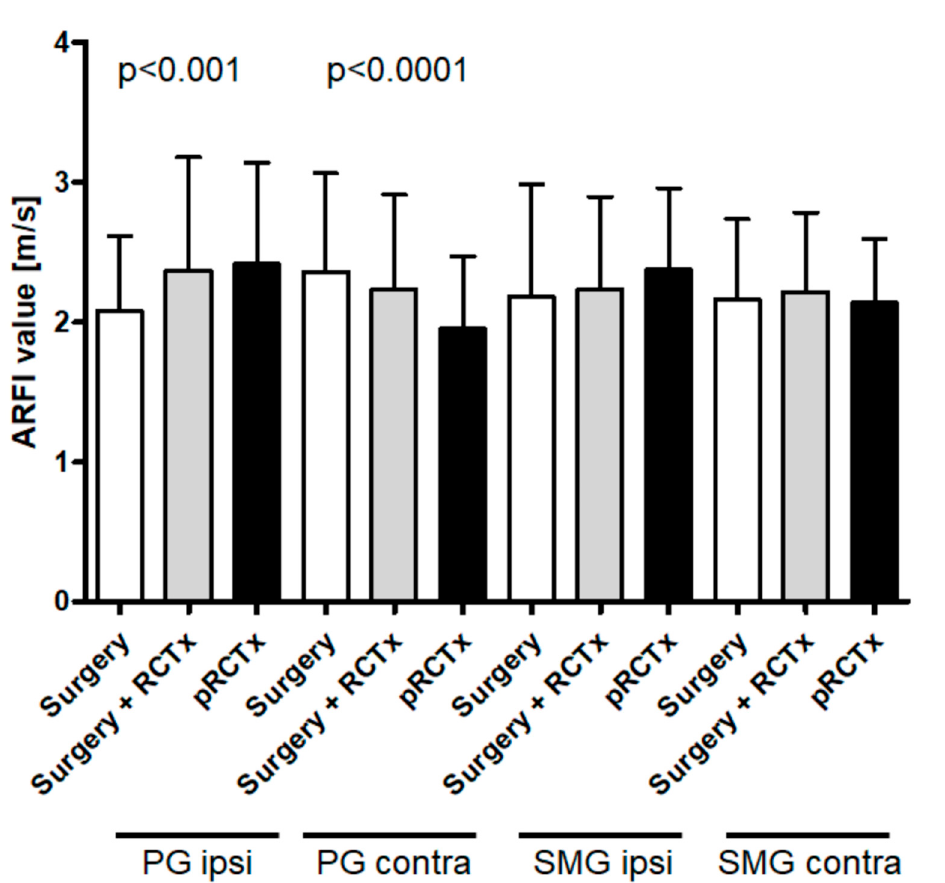
Figure 4. Stratification of the affection of ipsi- and contralateral salivary glands dependent on the therapeutic regime.